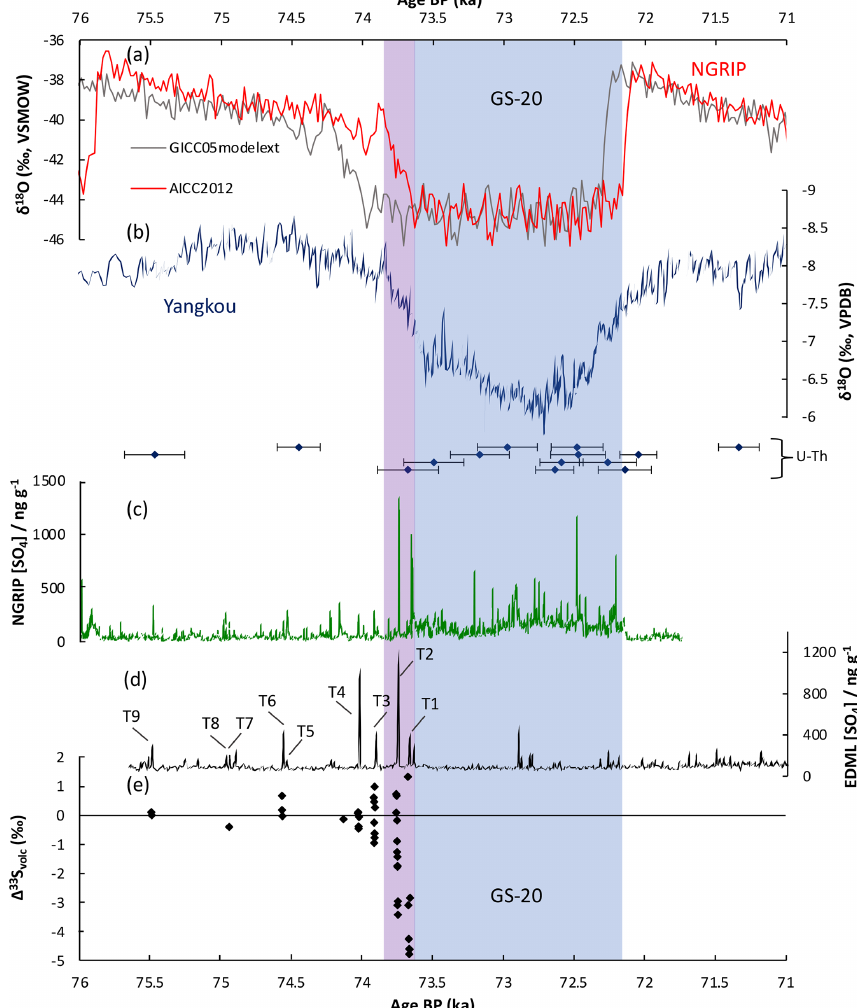
Figure 7. Paleoclimate indicators across GS-20 (highlighted in blue based upon NGRIP δ 18 O with the transition in purple). All ice core data are plotted using the AICC2012 age model unless indicated otherwise. (a) Ice core oxygen isotope data from NGRIP (North Greenland Ice Core Project Members, 2004) on both the AICC2012 age model (red) and GICC05modelext age model (Wolff et al., 2010b) (grey). (b) The δ 18 O speleothem records from Yangkou, China; the U-Th age data for Yangkou has also been included (blue diamonds) along with their associated 2 σ error (Du et al., 2019). (c) Continuous sulfate concentration in NGRIP and EDML (d) (Svensson et al., 2013). (e) (cid:49) 33 S volc measured for Toba candidates in this